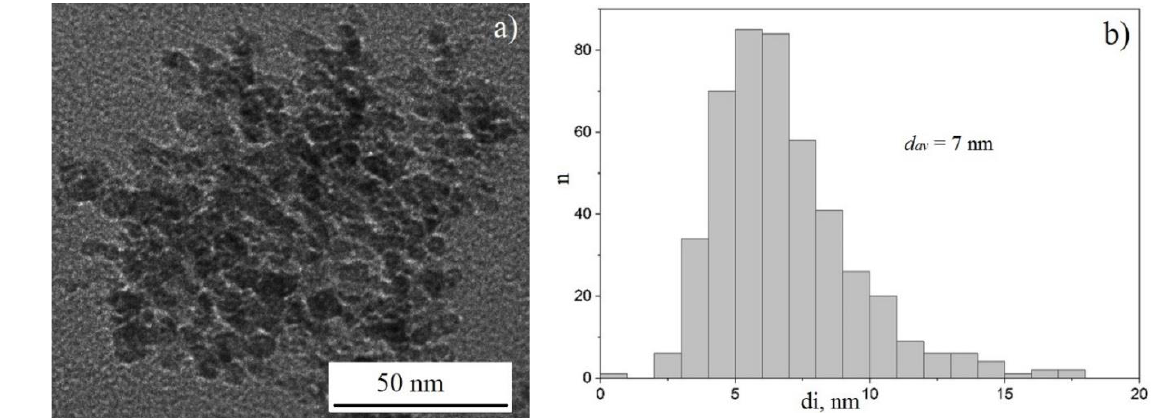
Figure 1. TEM image ( a ) and histogram of particle size distribution ( b ) in the ND powder. Table 1. Chemical composition (wt %) of the obtained